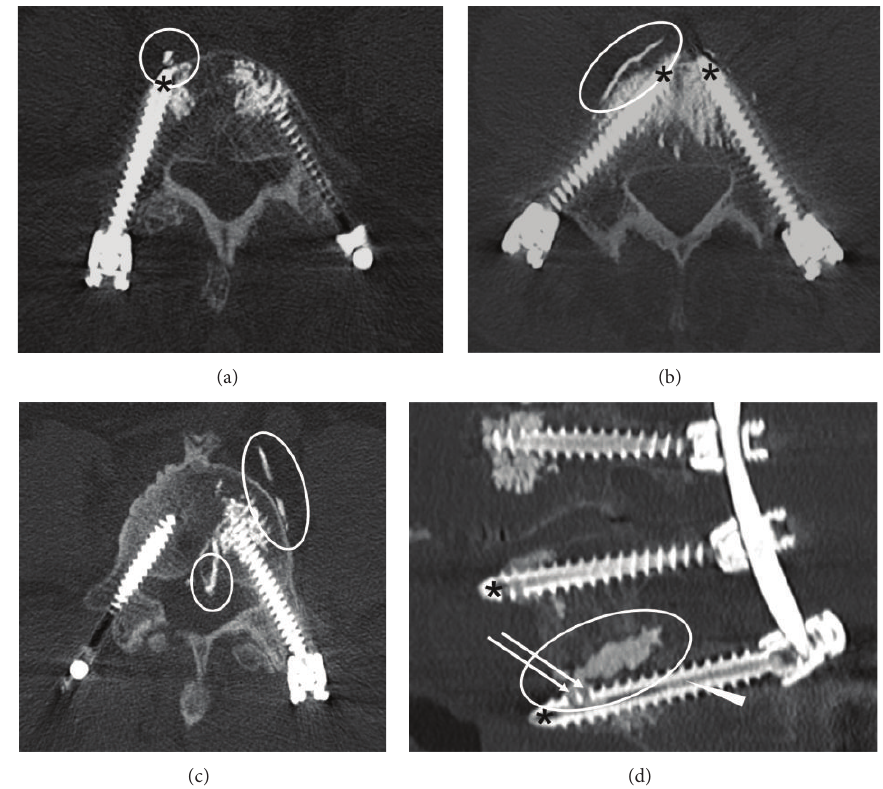
Figure 5: Cement extravasations. Postoperative computed tomography scans showing prevertebral ((a), (b)), paravertebral (c), epidural (c), and intradiscal (d) cement extravasations (encircled). Arrows (d) indicate fenestrations in the distal third of the thread; the arrowhead (d) indicates the hollow central shaft of the cannulated screw now filled with PMMA cement. Long screws with the tip of cannulated screws close to the anterior cortex of the vertebra (asterisks) might provoke prevertebral and paravertebral cement extravasations. Notice that the right screw (c) has not been cement-augmented due to local sclerosis of the vertebral body and therefore sufficient primary fixation